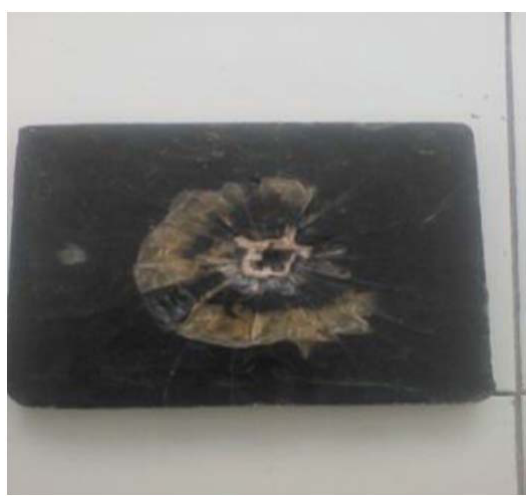
Figure 5. Specimen After Ballistic Testing